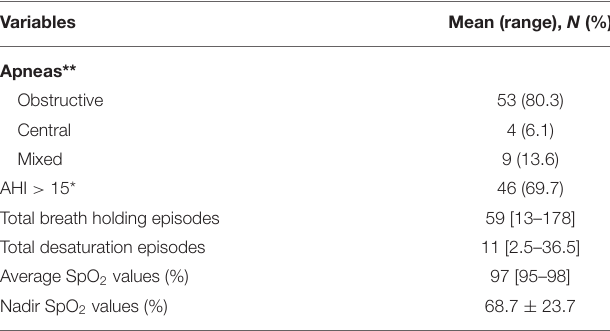
TABLE 2 | Baseline cardiorespiratory monitoring of the examined patients with RTT ( n =